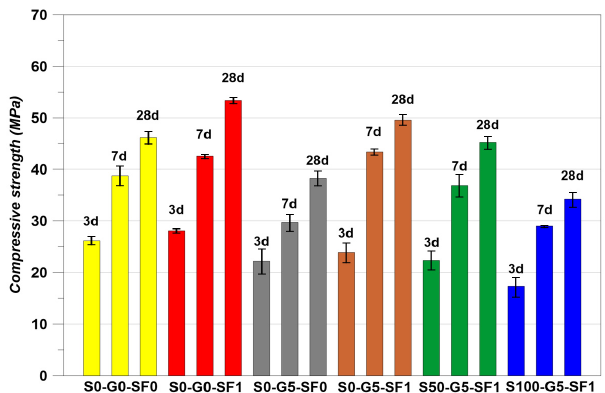
Figure 8. Compressive strength results.